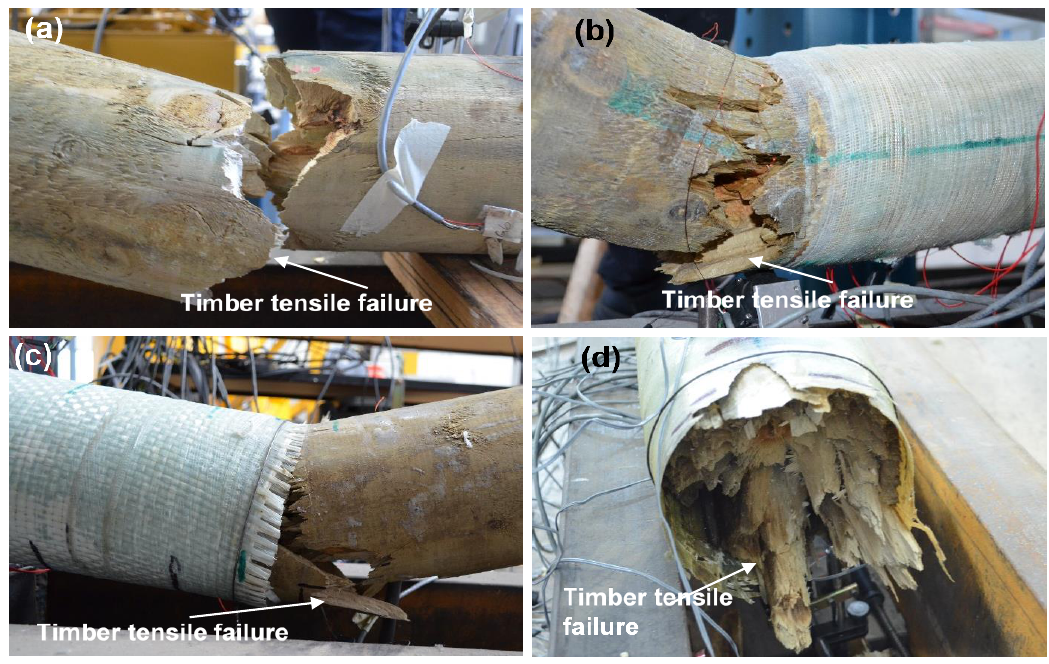
Figure 5. Failure modes of experimental specimens ( a ) TWE0 at 6.5 kN; ( b ) TWE20 at 5.93 kN; ( c ) TWE30 at 10.32 kN; and ( d ) TWE70 at 28.5